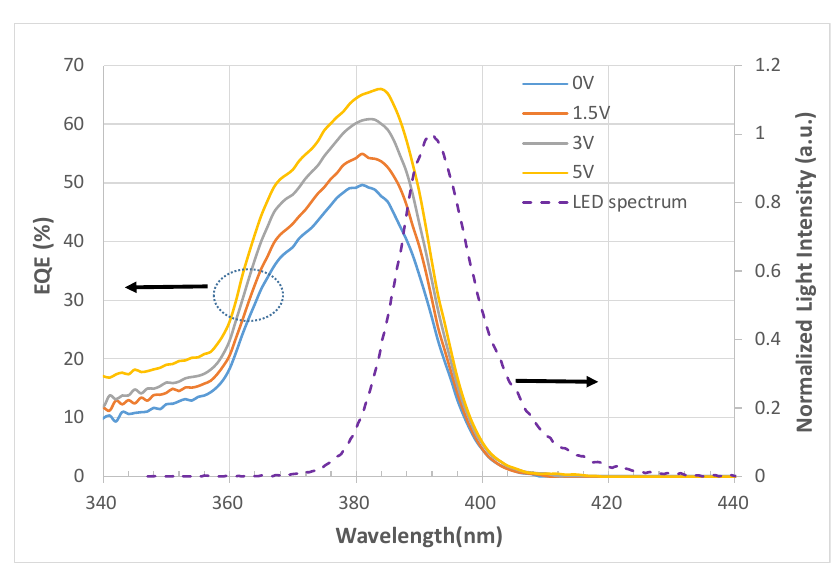
Figure 4. EQE versus wavelength at various biases at room temperature when measured as a p–i–n photodiode (in solid lines), and the emission spectrum when measured as an LED (in a dashed line).